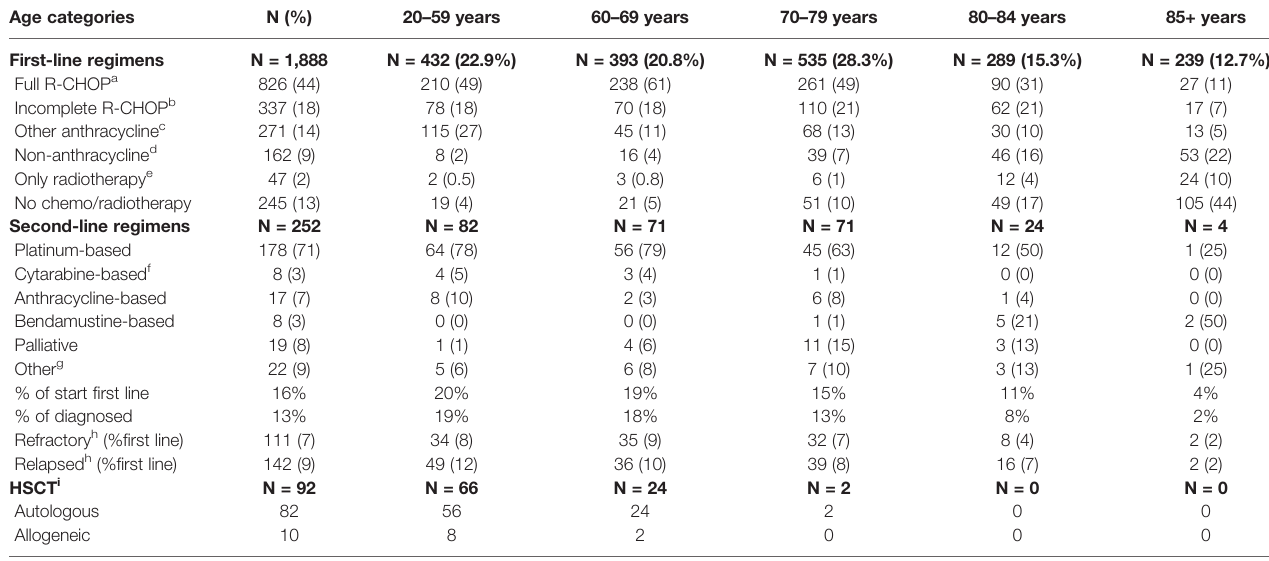
TABLE 1 | Grouped fi rst- and second-line treatments, including HSCT, by age